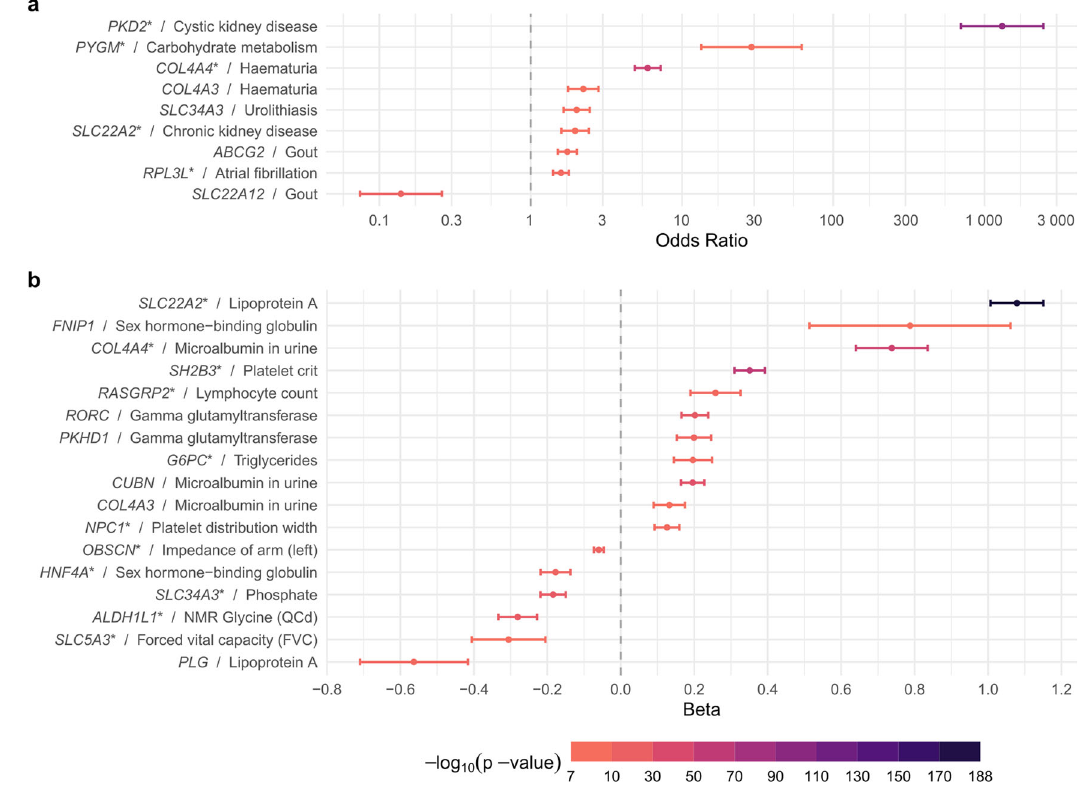
Fig. 6 | Phenome-wide association study for kidney genes. Phenome-wide association study of genes identi fi ed in our single variant ExWAS or gene-based study with other phenotypes in the UK Biobank. For every gene, the odds ratio or beta of the UK Biobank phenotype with the smallest p -value of a gene-based association test is displayed. Genes with multiple signi fi cant phenotype associa- tions aremarked with anasterisk(*).Fullresults, including numbersof biologically independentsamplesforallshownUKphenotypes,areavailableinSupplementary